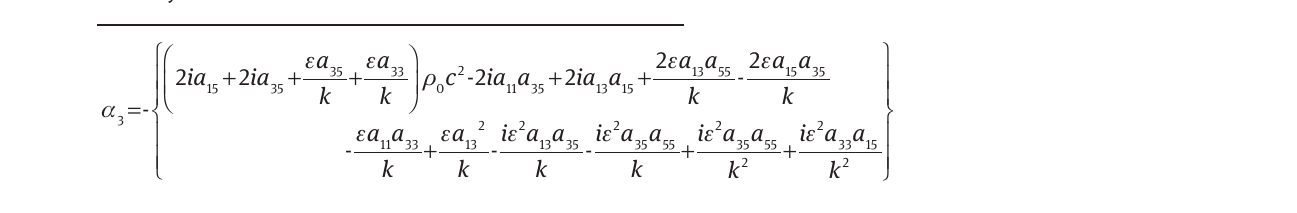
investigated. The dispersion analysis shows that the phase velocity of the Rayleigh waves is influenced by the inhomogeneity, gravity, and strain rate parameters. The numerical results are discussed by plotting the cor- responding graphs between the phase velocity and the wave number. It can be concluded from the graphs that the inhomogeneity parameter and thickness of the layer have a considerable effect on the phase velocity. The gravity parameter has no significant effect on the phase